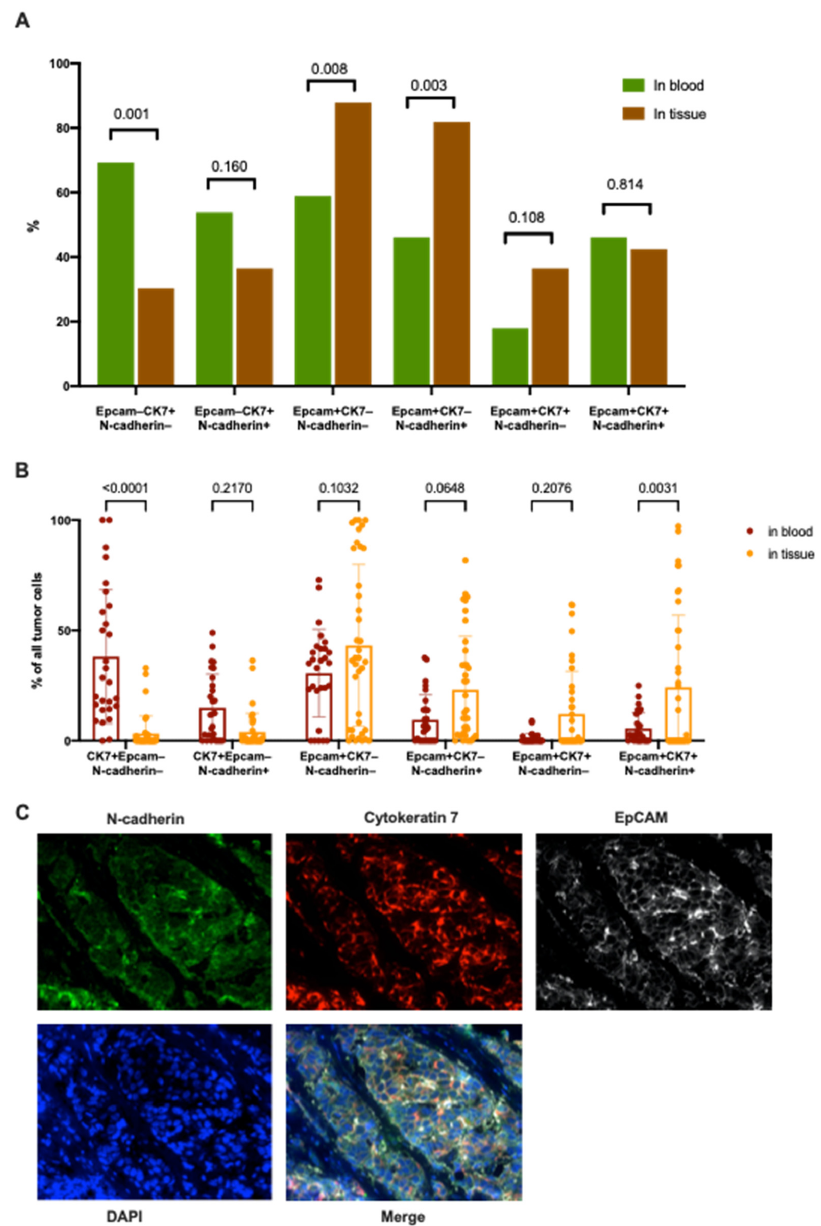
Figure 7. The frequencies ( A ) and number ( B ) of tumor cells in the primary tumor and among CTCs which co-express of CK7, EpCAM, and N-cadherin in the same cell. Invasive breast carcinoma cells stained by CK7, EpCAM, and N-cadherin ( C ).